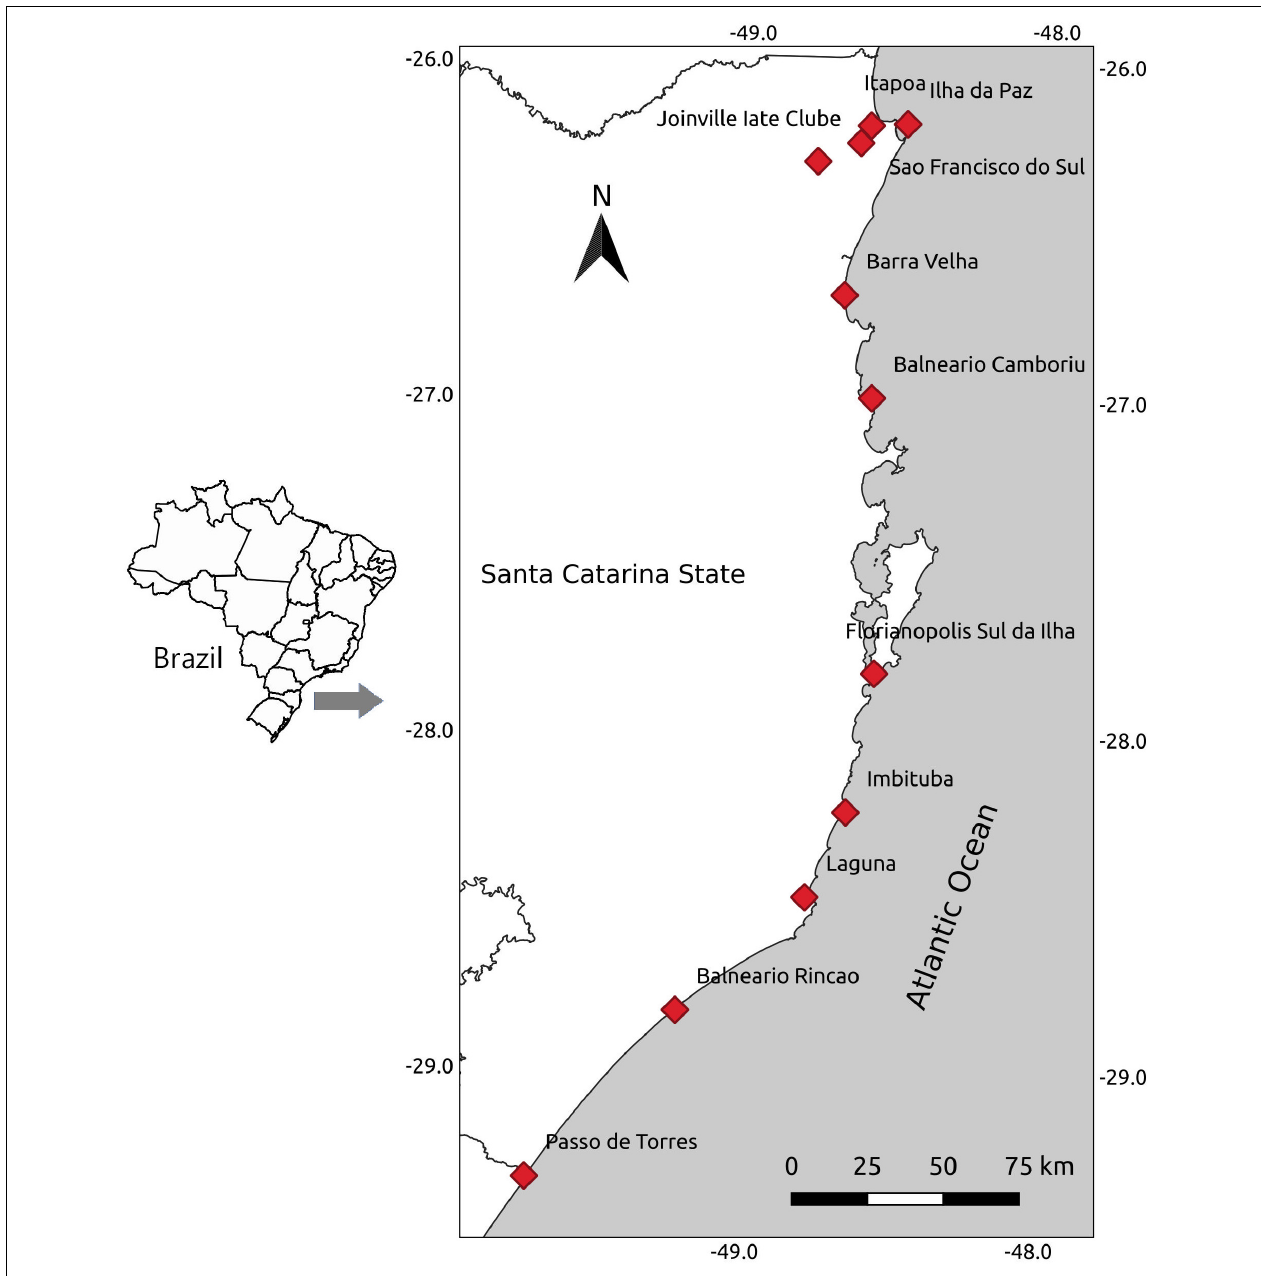
FIGURE 5 | SCTGN tide gauges along the coast of the Santa Catarina